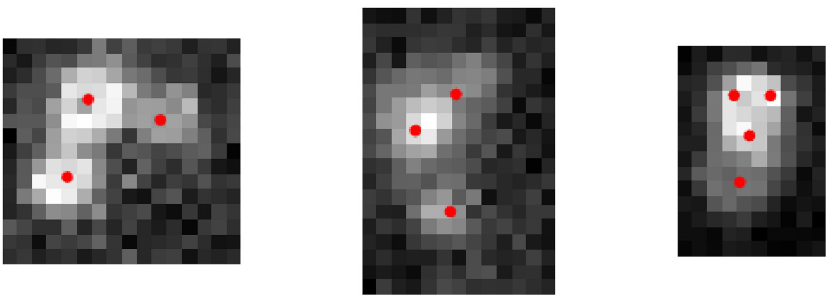
Fig 5. Clusters may be composed of cells having different diameters and fluorescences. In the first two examples the cells were identified correctly, but in the third example the algorithm overfitted 4 cells instead of 2. The mean of the fitted gaussians are represented by red dots.